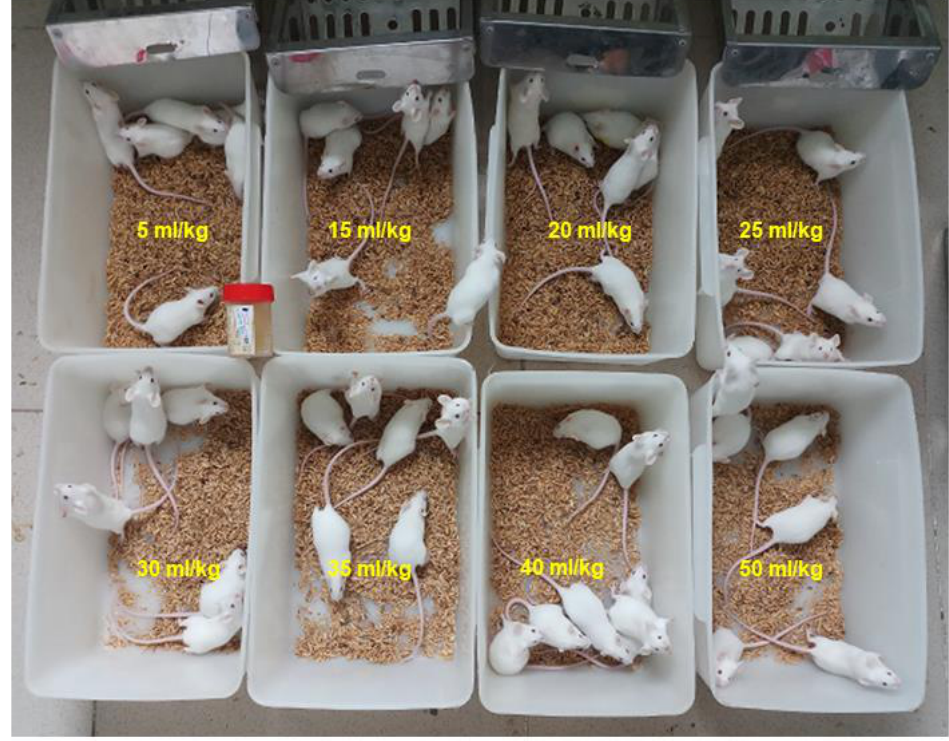
Figure 9. Optical images of mice administered with various doses of 300 ppm Se NPs.